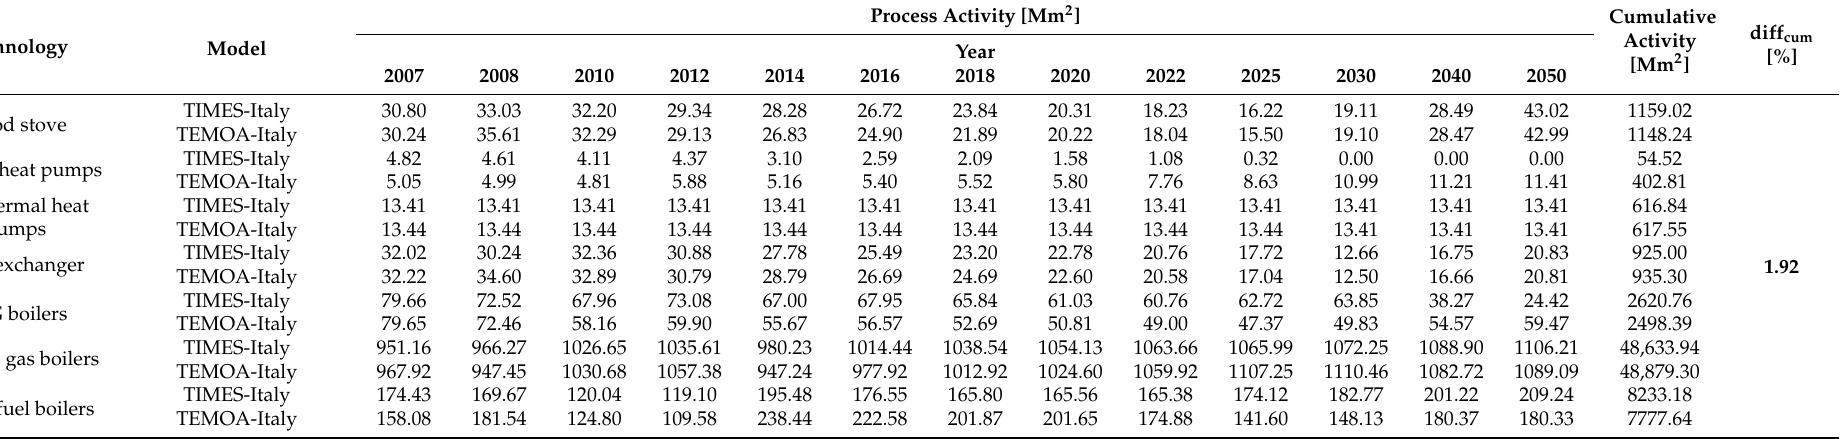
Table A7. Activity of residential space heating technologies and cumulative activity along the entire time horizon, compared for TIMES-Italy and TEMOA-Italy results. Evaluated average relative difference on cumulative